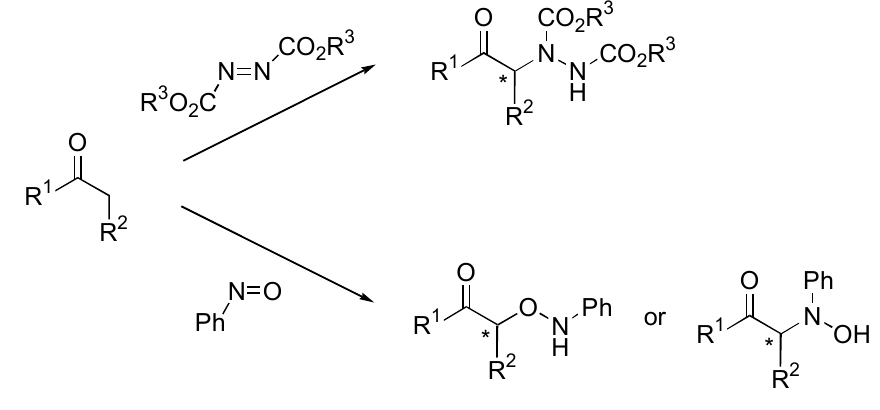
Figure 1. Asymmetric direct  -functionalization of carbonyl with oxygen and nitrogen